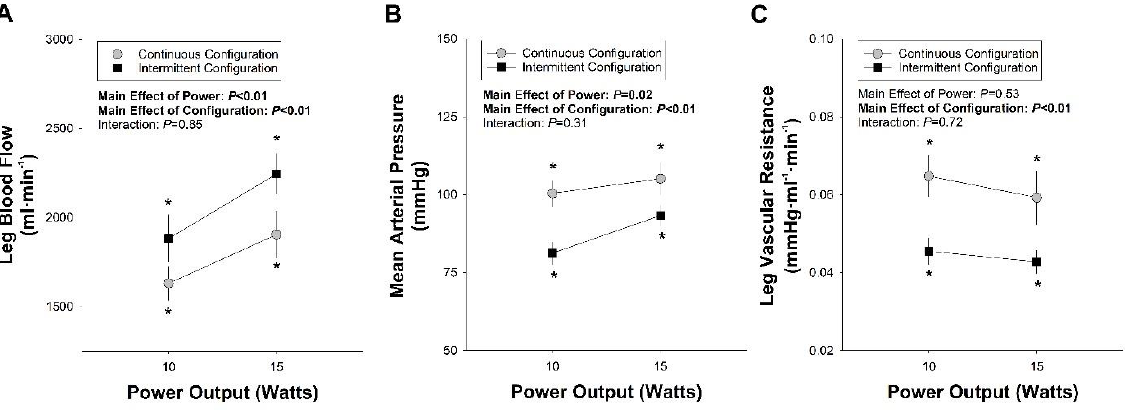
Figure 2. Impact of Interrepetition Rest on Hemodynamics during Single-Leg Knee Extension Resistance Exercise. ( A ) Leg blood flow, ( B ) mean arterial pressure and ( C ) leg vascular resistance during single-leg knee extension with (i.e., intermittent configuration) or without (i.e., continuous configuration) interrepetition rests. * Significantly different ( p < 0.05) from the same power output under another configuration.